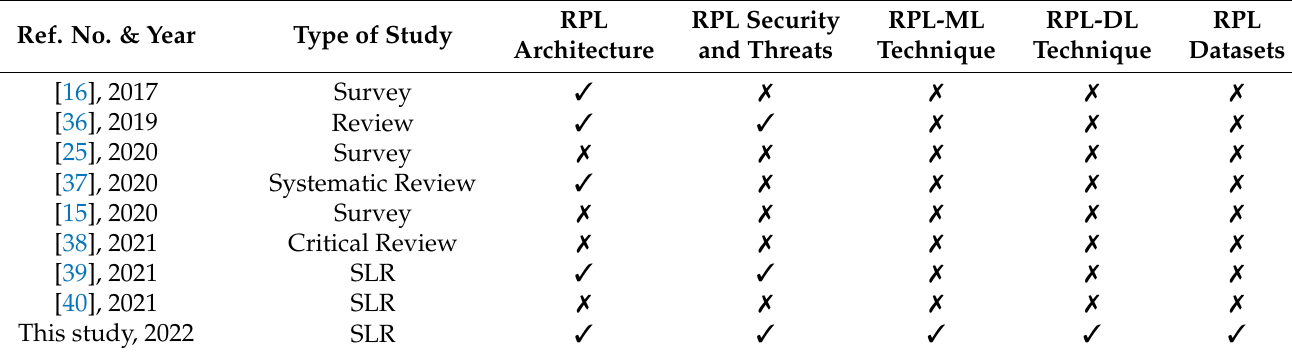
Table 1. Comparison of our SLR With existing literature